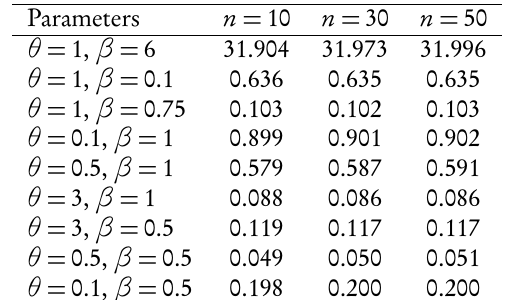
Mean squared errors of (cid:98) β